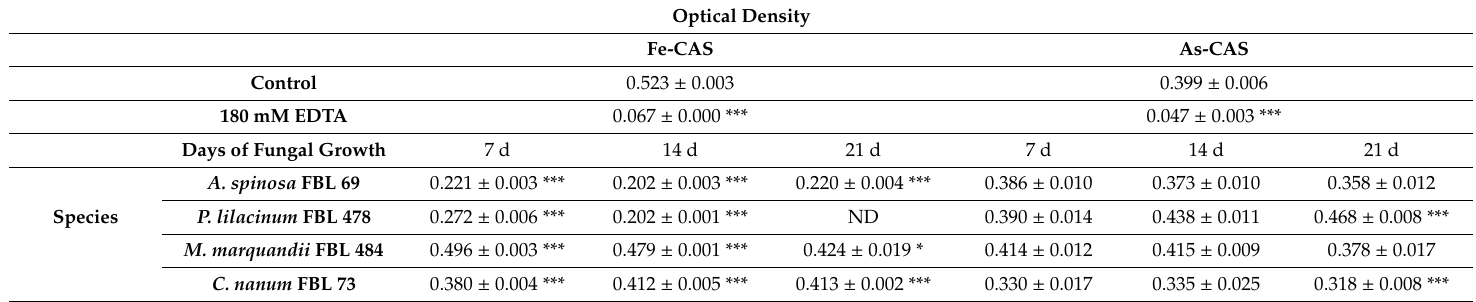
Table 6. Optical density (OD) measurements for the tested species in the Fe-CAS and As-CAS assays. Data are expressed as the mean ± standard error of independent biological replicates a